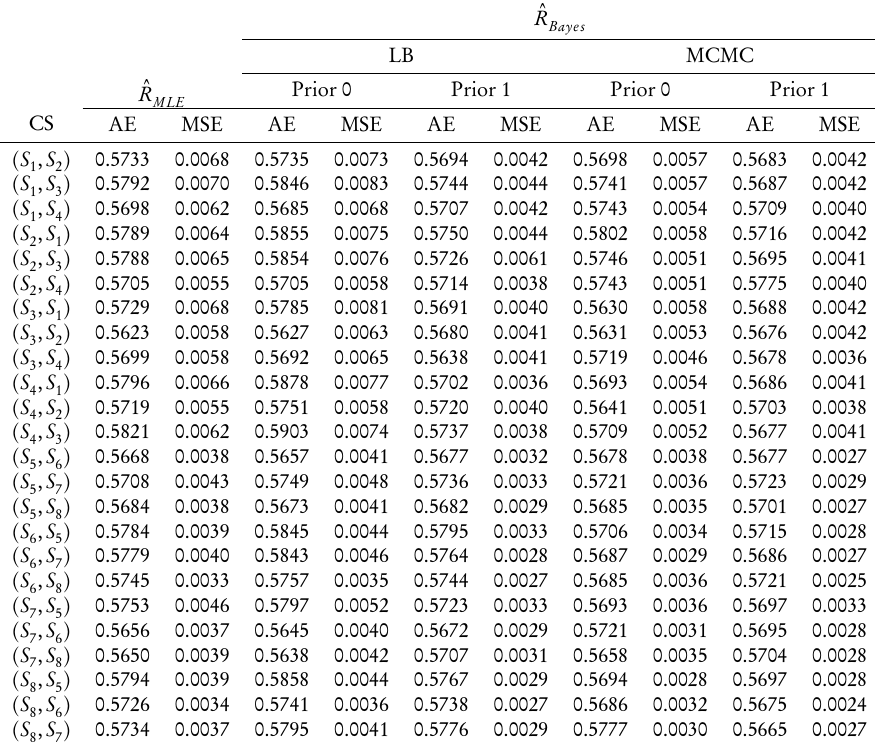
The AE and MSE of the ML and Bayes estimates of R when α = 1.5, β = 4.5, λ = 1 and R = 0.5714 .